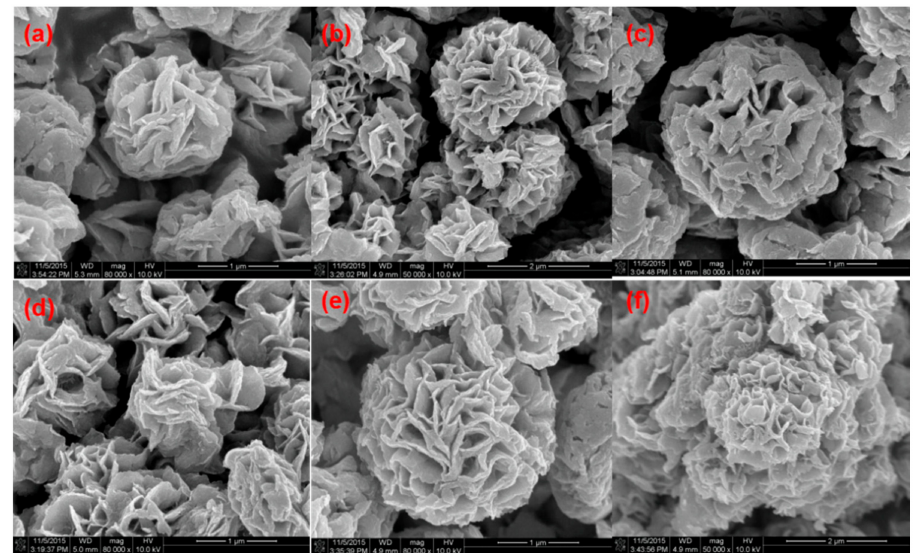
Figure 5. SEM images of BiOCl ( a ) and (0.5%, 1%, 1.5%, 2% and 2.5%) Dy-doped BiOCl ( b – f ).